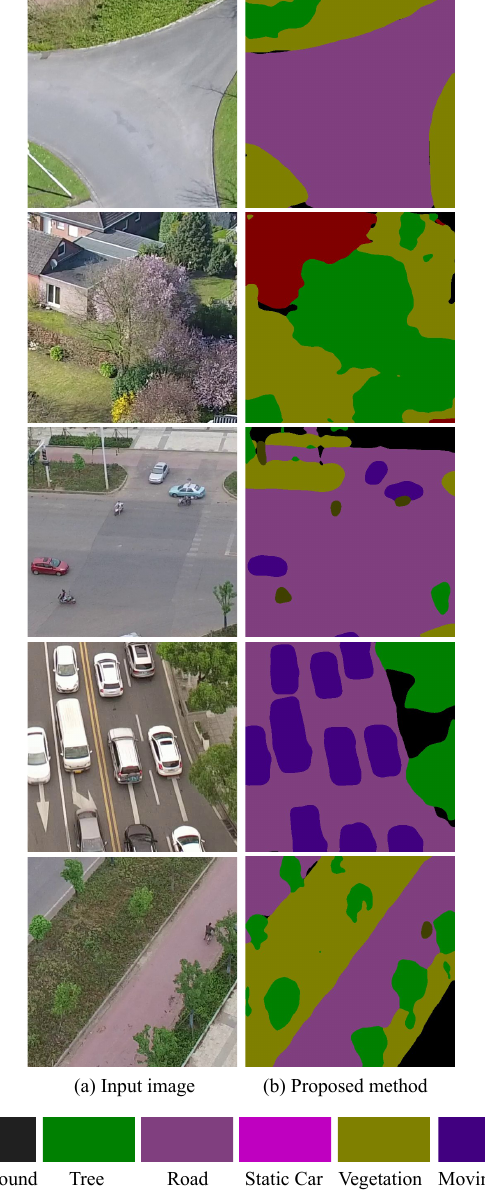
Figure 5. Qualitative prediction results using the UAVid test